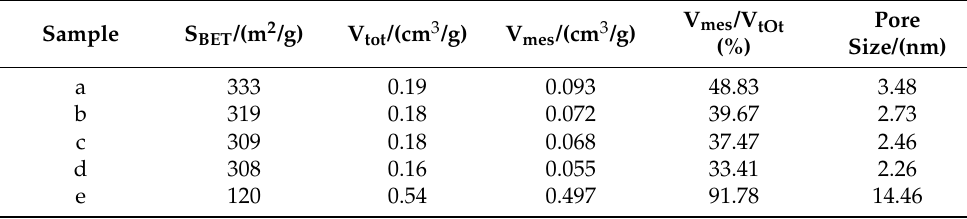
Table 1. Textural properties of ZSM-5 and products with different Zn/Si